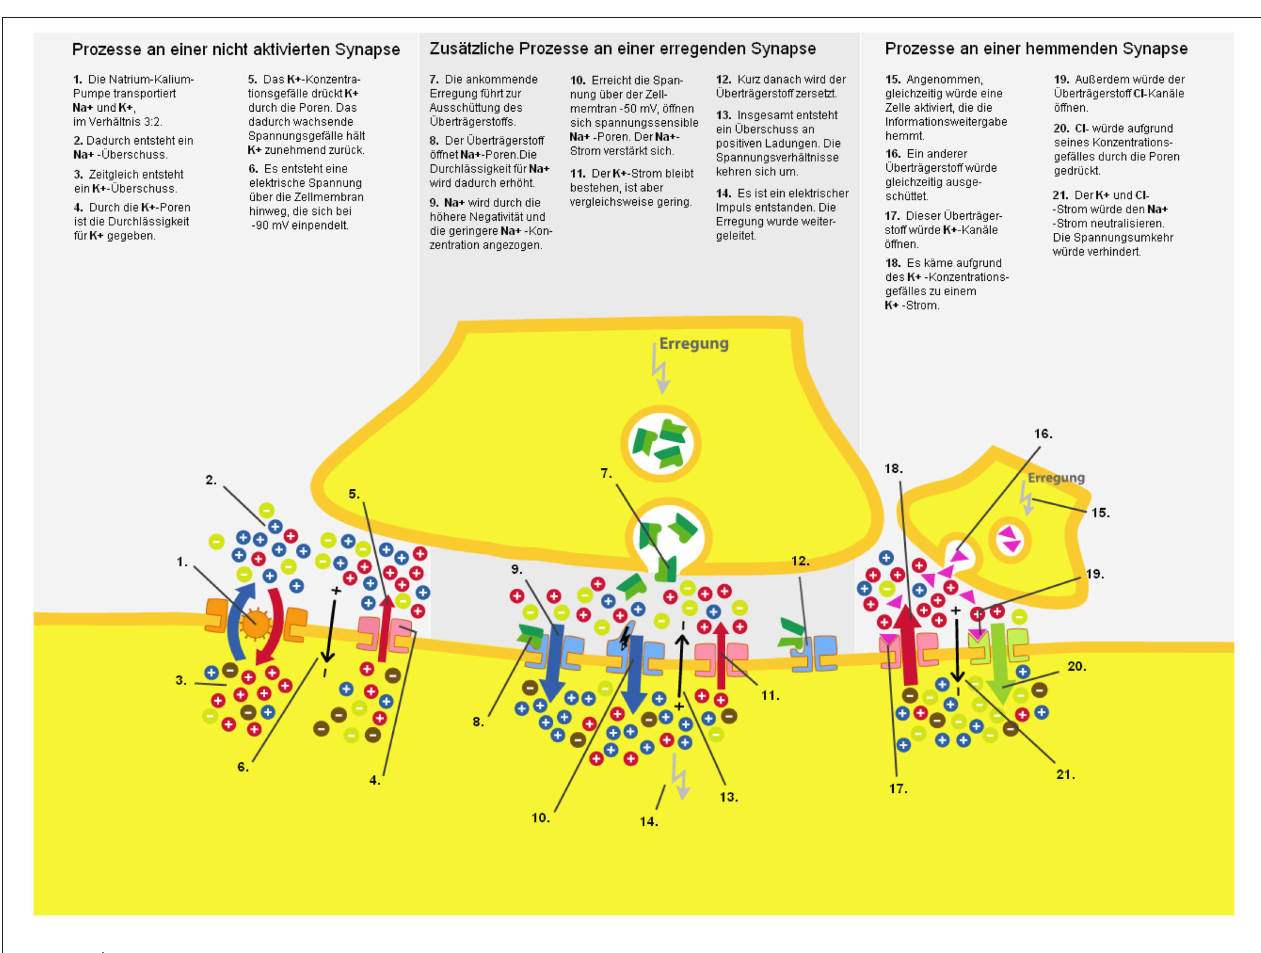
FIGURE 2 | Separated text-picture presentation in Experiment